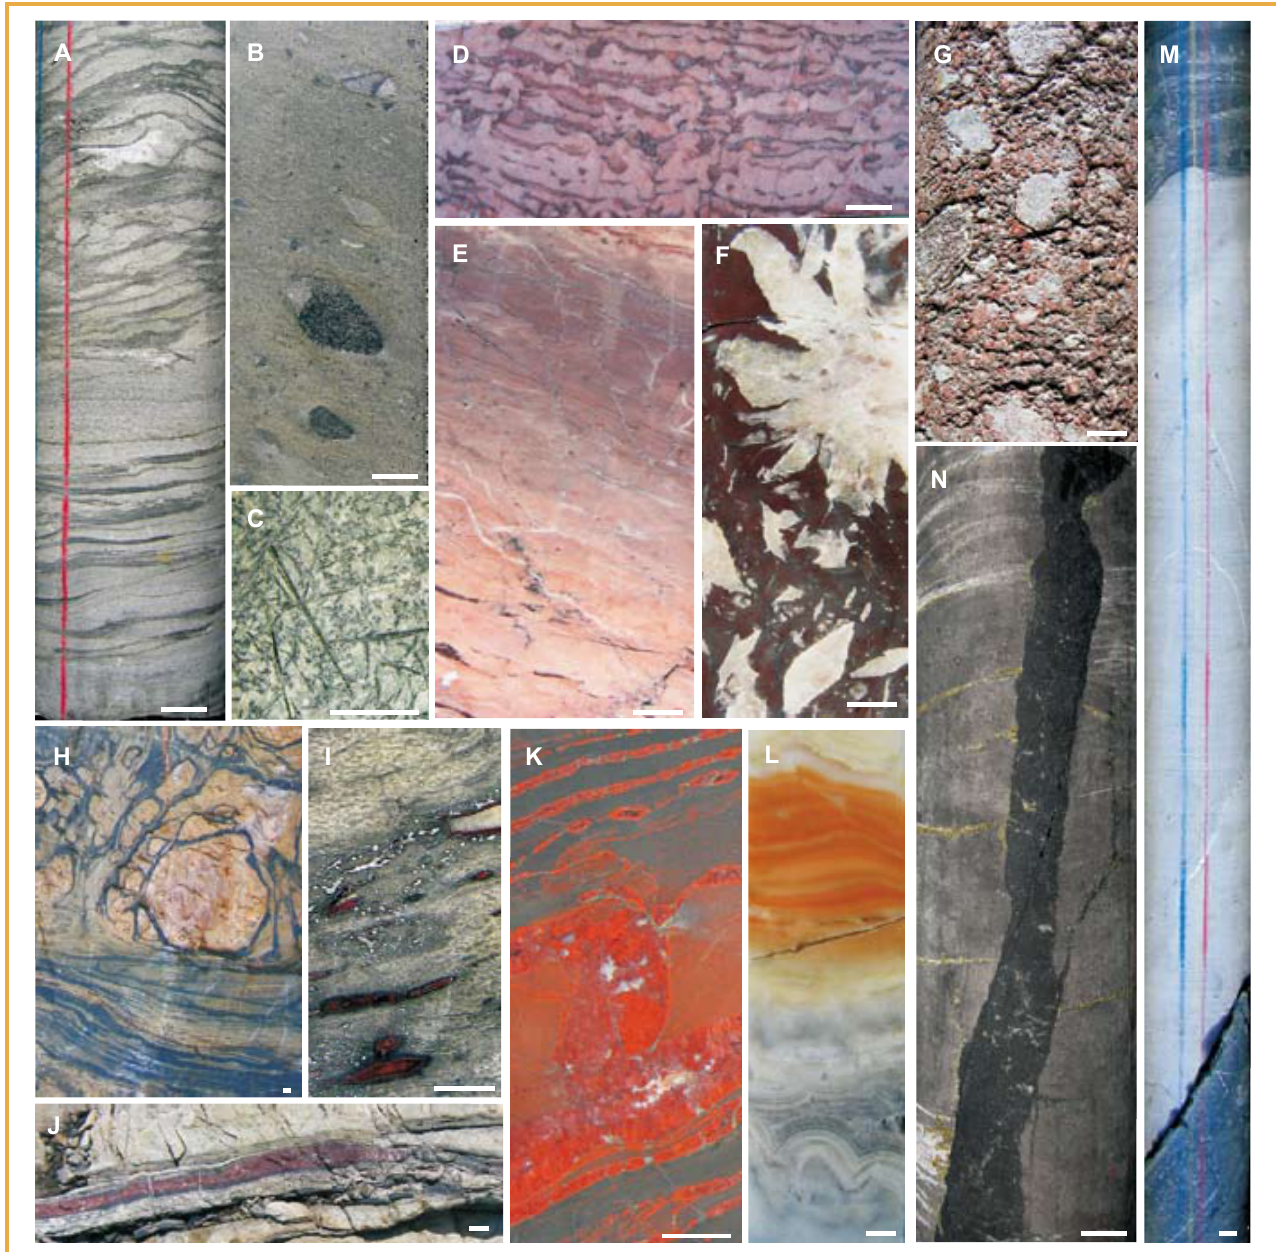
Figure 6. Major Paleoproterozoic paleoenvironmental events documented in the FAR-DEEP cores and adjacent outcrops. [A] Sandstone-shale from drillhole 1A with tidal bedding formed at the start of the GOE. [B] Diamictite accumulated during the Huronian-global glaciation; drillhole 3A. [C] Spinifex-structured komatiites overlying the diamictites; drillhole 3A. [D] Jatuli-age, red, stromatolitic, 13 C-rich, dolostone recording the unprecedented perturbation of the global carbon cycle during the Lomagundi-Jatuli Event; red color is indicative of oxic environment associated with GOE; drillhole 10A. [E] Post-Lomagundi-Jatuli, pink, isotopically "normal", dolostone recording the recovery from the perturbation in the global carbon cycle; drillhole 8B. [F] Dolomite-quartz pseudomorphs after gypsum rosette and crystals emplaced in red clay; abundant Ca-sulfates suggest a significant ocean sulfate reservoir; drillhole 10B. [G] Dissolution of anhydrite and halite resulted in porous appearance of matrix-supported conglomerate; drillhole 11A. [H] ~2060-Ma weathering surface imprinted in hematite-cemented (black) felsic lava-breccia in vicinity of drillhole 7A; this is indicative of oxic meteoric and ground waters during the GOE. [I] Jasper-filled amygdales (dark red) in oxidized felsic lava from drillhole 6A; this may record an upper mantle oxidizing event. [J] Jasper vein in dacitic lava near drillhole 7A; such veins are truncated by overlying sediments and are the product of subaerial, syn-volcanic hydrothermal activity. [K] Greywacke-hosted jasper layers and beds precipitated from sub-aqueous hydrothermal system; drillhole 8B. [L] The earliest known travertines on Earth from drillhole 5A. [M] 13 C-depleted carbonate concretion incorporating carbon derived from oxic recycling of the organic matter; drillhole 12B. Bar scales in all photos are 1 cm. [N] Pyrobitumen vein representing a 2000-Ma oil migration pathway; drillhole 12A. These units contain both mass-independent and mass- dependent fractionation of sulfur